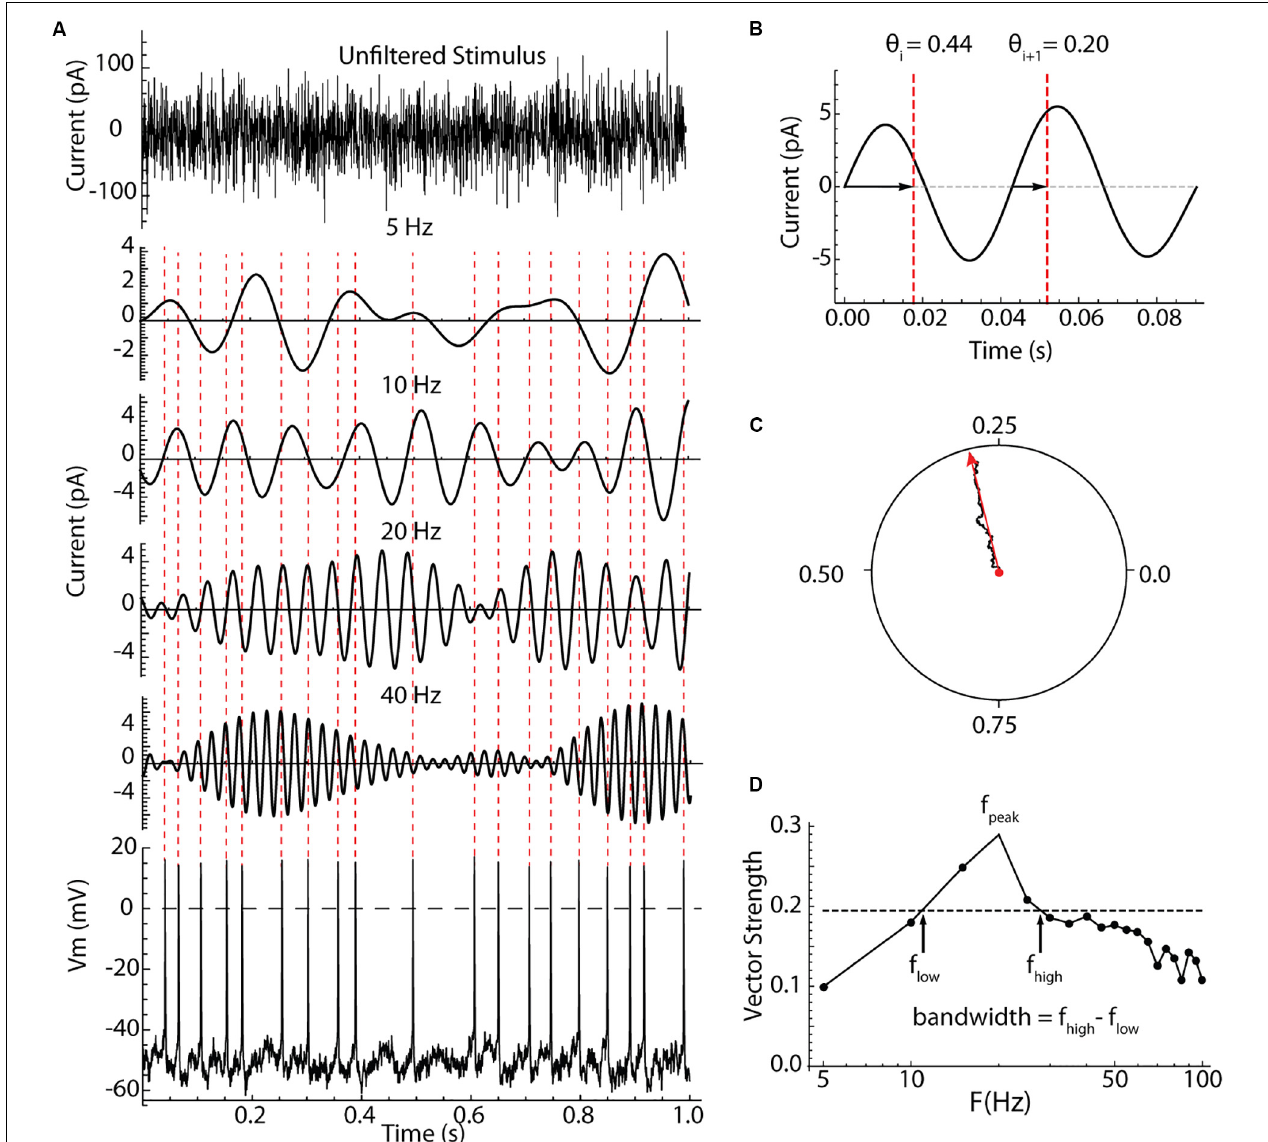
FIGURE 2 | Measurement of spiking resonance. (A) An example 1 s of the injected current (top), bandpass filtered components of the same current centered on different frequencies, and the resulting voltage waveform and perturbed spiking in a striatal LTS interneuron. The spike times are indicated with dotted lines crossing the filtered current waveforms. (B) Measurement of spike phases on the filtered waveform. Phase was measured between positive-slope zero crossings. (C) The summation of phase measurements from many action potentials as a vector sum. The resultant vector in red, points in the direction of the average phase, and its length is the vector strength. (D) A spectrum of vector strength measurements from an example LTS interneuron taken for a range of bandpass center frequencies. The frequency producing the peak resonance, f peak , and the half-width of the spectrum (bandwidth) were measured as shown using the half-height taken between the maximum and minimum vector